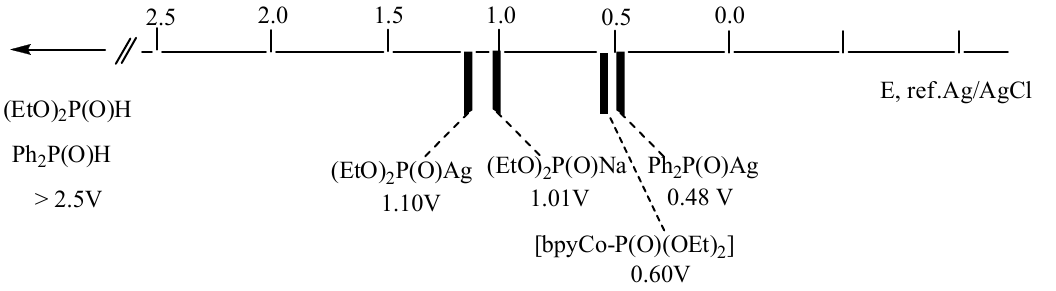
Figure 1. Oxidation potentials of some metal phosphonates.